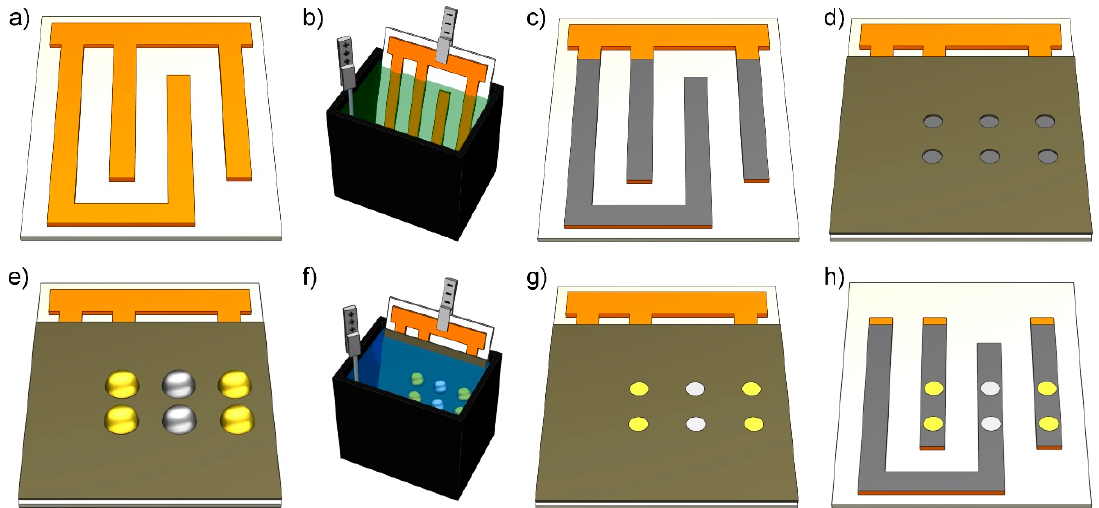
Figure 1. Parallel electroplating using printed gels. ( a ) Patterning of a copper polyimide foil laminated on a dicing tape; ( b ) nickel electrodeposition; ( c ) a nickel-coated substrate; ( d ) a substrate with a laminated mask; ( e ) a printing droplet of gold and silver electrolytes mixed with agarose gel; ( f ) electrodeposition in a 1-M potassium nitrate bath; ( g ) electrodeposited layers of gold and silver; and ( h ) detachment of the mask and cutting o ff of the contact pad to separate the